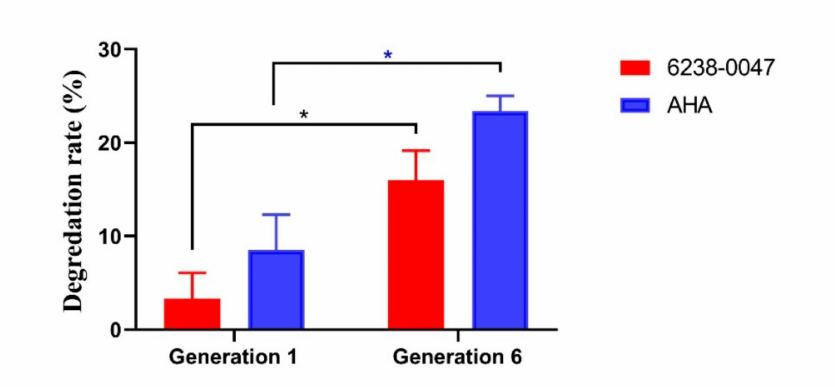
Figure 6. Chemical degradation rates of AHA and 6238-0047. The results were presented as the mean ± SEM. Asterisk (*) indicates the significant di ff